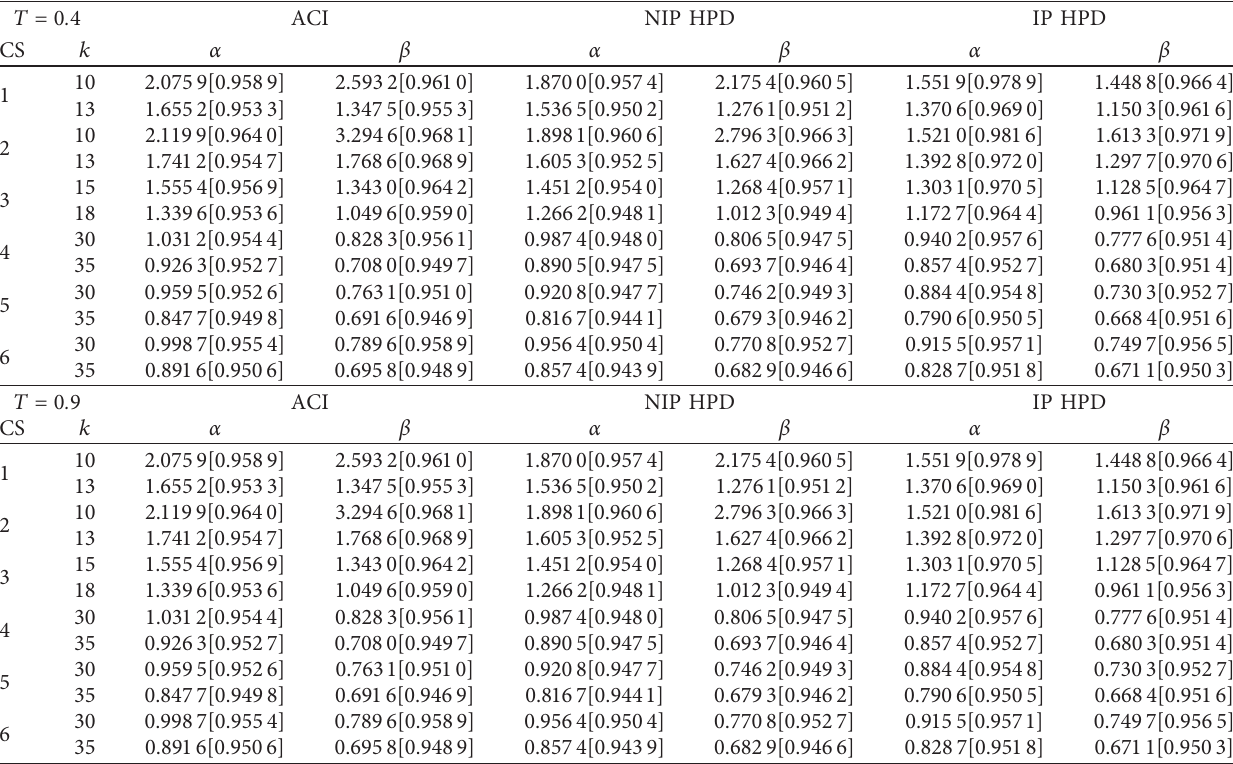
Table 4: AWs and CPs (within brackets) of the ACIs and HPD credible intervals under generalized progressively hybrid censored data with ( β , α ) � ( 1 . 5 , 1 )